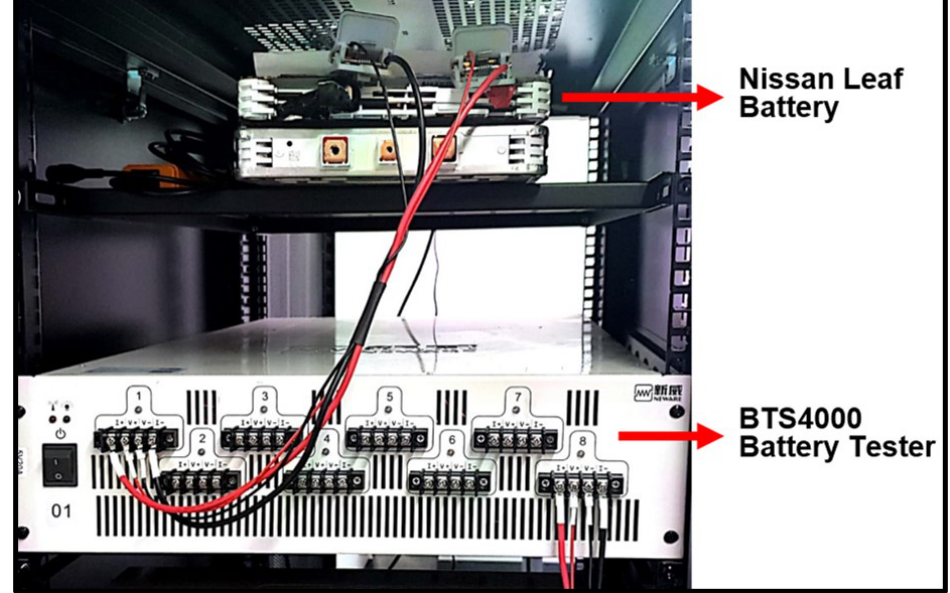
Figure 5. Nissan leaf pouch cell connected to the Neware BTS4000 battery cycler, with magnetic sensor array module placed on top of the